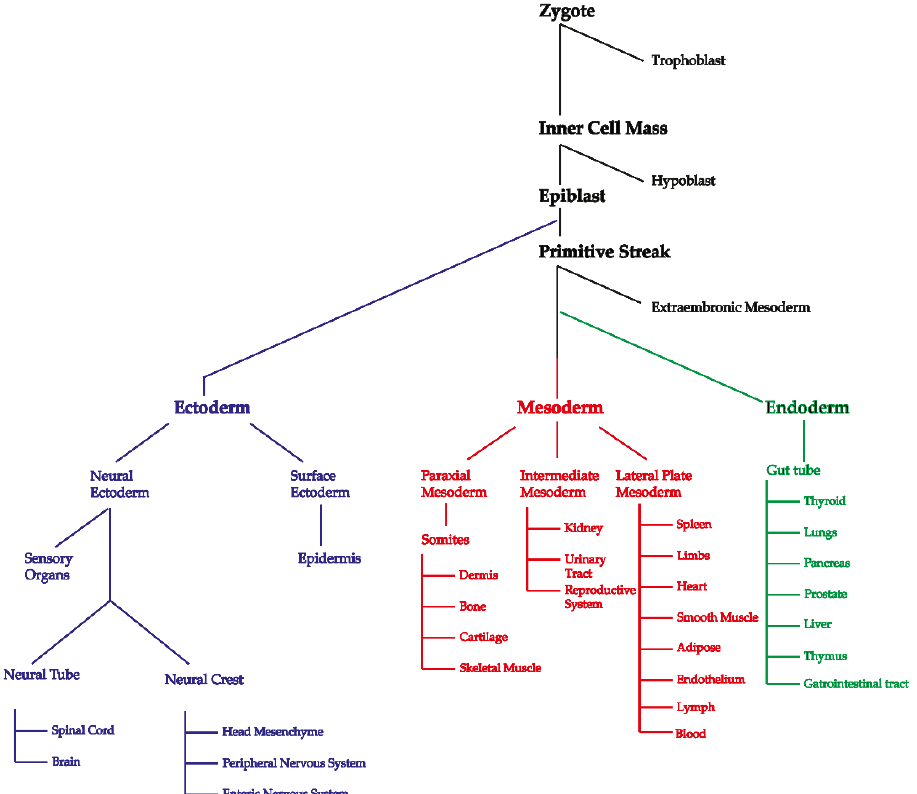
Figure 1. Developmental lineage tree highlighting where each of the three germ layers branch is from and what structures and organs they form or contribute to. Blood samples would be mesodermal, saliva samples would contain leukocytes of mesodermal origin and epithelial cells of ectodermal origin from the surface ectoderm [22], and unsorted gut samples would contain derivatives of all three germ layers, with ectodermal neural crest making up for the minority of cells. This figure was adapted from LifeMap (http://discovery.lifemapsc.com (accessed on 16 November 2018)).